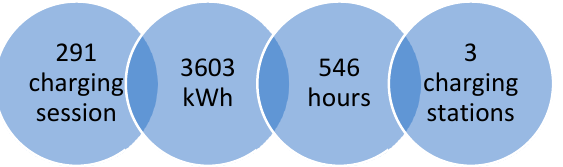
Figure 5. Key information about the first three EV charging stations in Cluj-Napoca in the first 3 months.